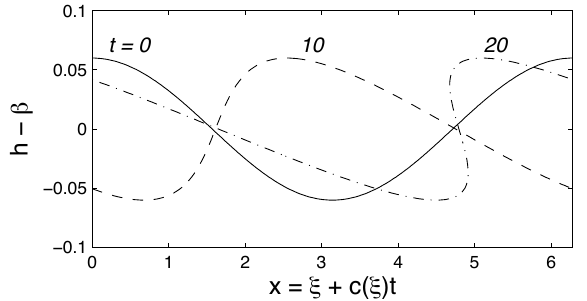
Fig. 13. Evolution of initially sinusoidal isopycnal h − β corre- sponding to β = 0 . 4 at the times